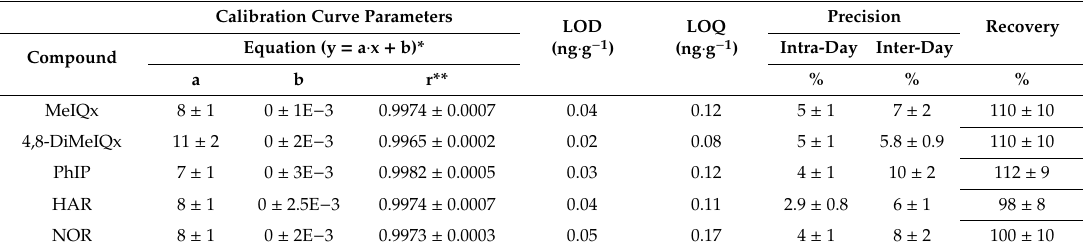
Table 1. Validation of the LC-MS / MS method used for quantitation HCAs in grilled